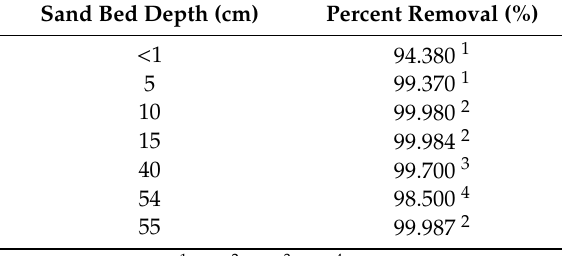
Table 1. Literature values for percent removal of Escherichia coli ( E. coli ) vs. depth in slow-sand / biosand filters derived from physical